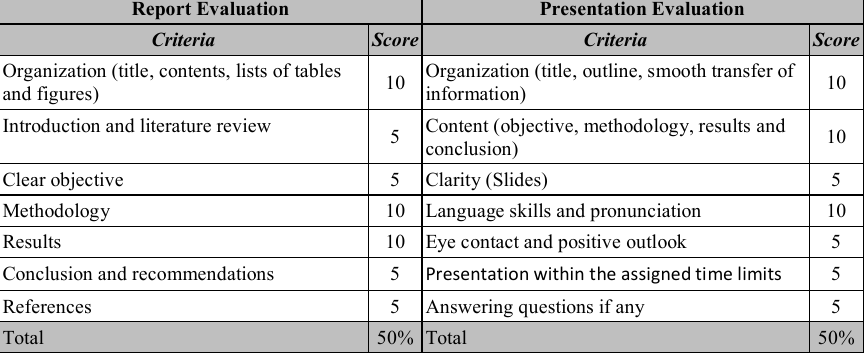
Table 6. Report and presentation evaluation